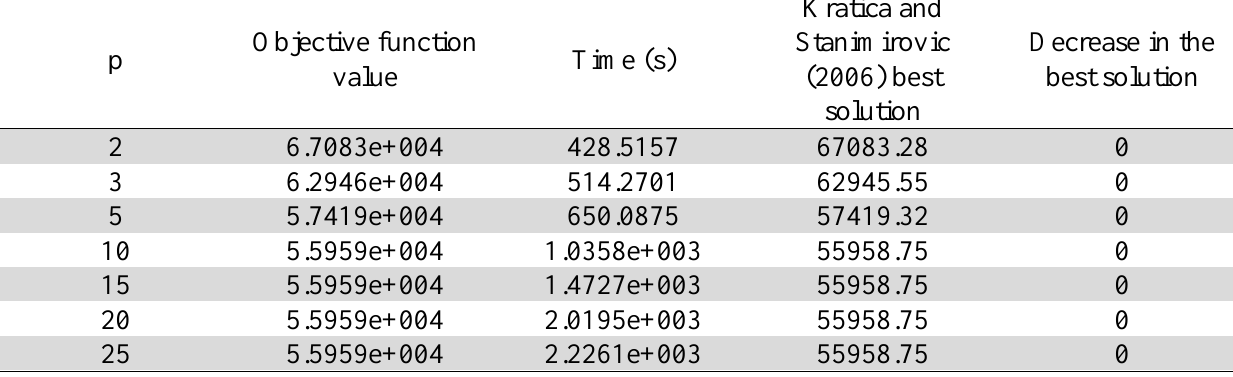
Results of the GA for different AP data set instances